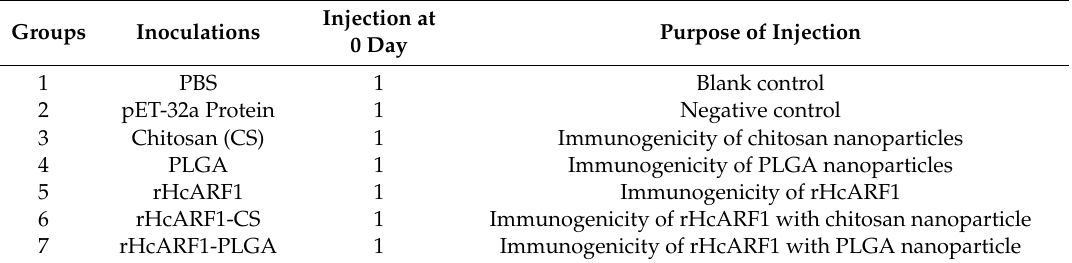
Table 1. Nature and composition of the di ff erent materials (vaccine) injected into mice and evaluated the type of immune